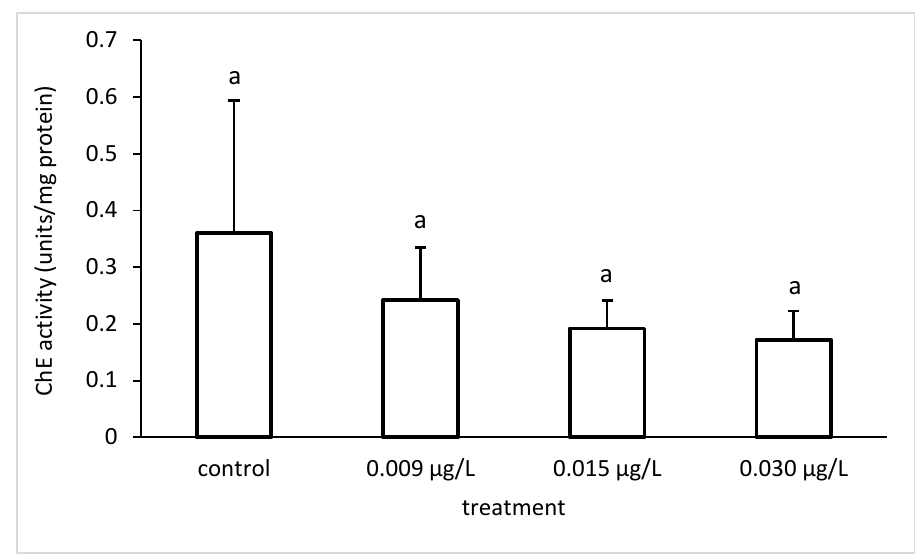
Figure 5. Cholinesterase (ChE) activity in common carp liver under different CPF exposures. Bars represent means ± SD of the control and experimental groups; ‘a’ letter represents that there were no significant differences among treatments ( p > 0.05).